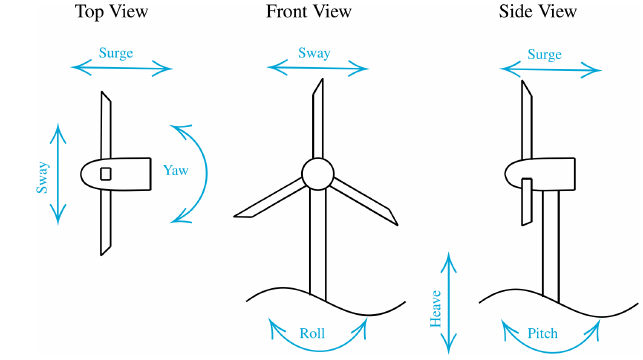
Figure 1. Degrees of freedom of a